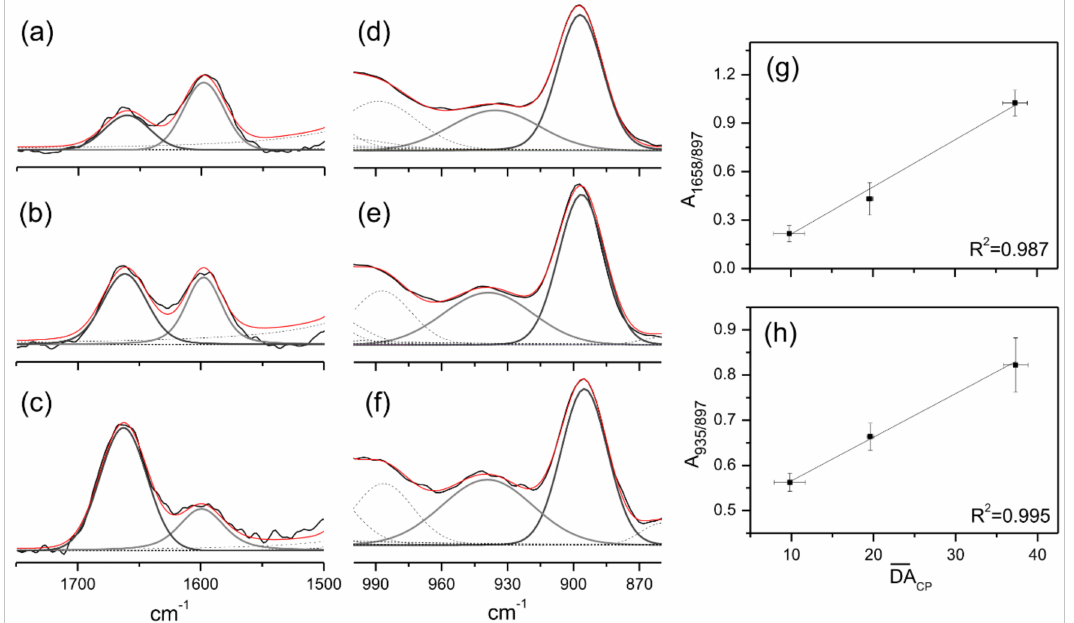
Figure 1. Deconvolution procedure of the assigned 1750–1500 cm − 1 ( a – c ) and 1000–860 cm − 1 ( d – f ) intervals of Ch3 × 6 h ( a , d ), Ch2 × 6 h ( b , e ) and Ch1 × 6 h ( c , f ) FT-Raman spectra using Voigt functions. Correlation between the normalized area and the calculated DA CP values ( g , h